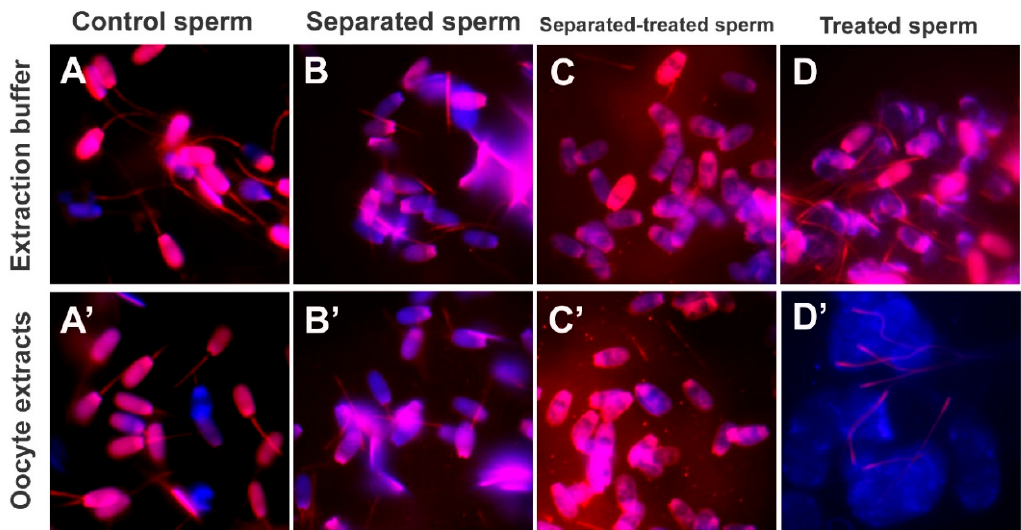
Figure 5. Sperm head expansion during oocyte extract co-incubation. Intact spermatozoa ( A , A’ ) and sperm heads and tails separated by sonication ( B ) were incubated with oocyte extracts or with extraction buffer as a control. Both the intact spermatozoa and the separated sperm heads and tails were subsequently treated with lysolecithin and DTT and co-incubated with porcine oocyte extracts for 24 h ( C , D ). The control sperm fractions incubated with oocyte extraction buffer ( D ) did not show signs of sperm head expansion, but the heads of spermatozoa exposed to oocyte extracts appeared enlarged ( D’ ) at the end of incubation. Sperm heads separated by sonication did not swell during prolonged incubation with oocyte extracts ( B’ , C’ ). Original magnification: 1000×.